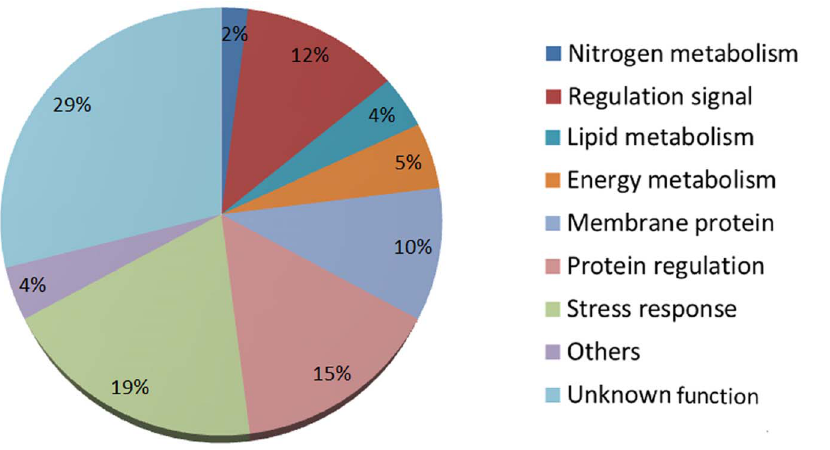
Figure 5. Expert annotations of transcripts containing polymorphisms or differential gene expression between Tiso-Wt and Tiso- S2M2. Transcripts were sorted according to major cell